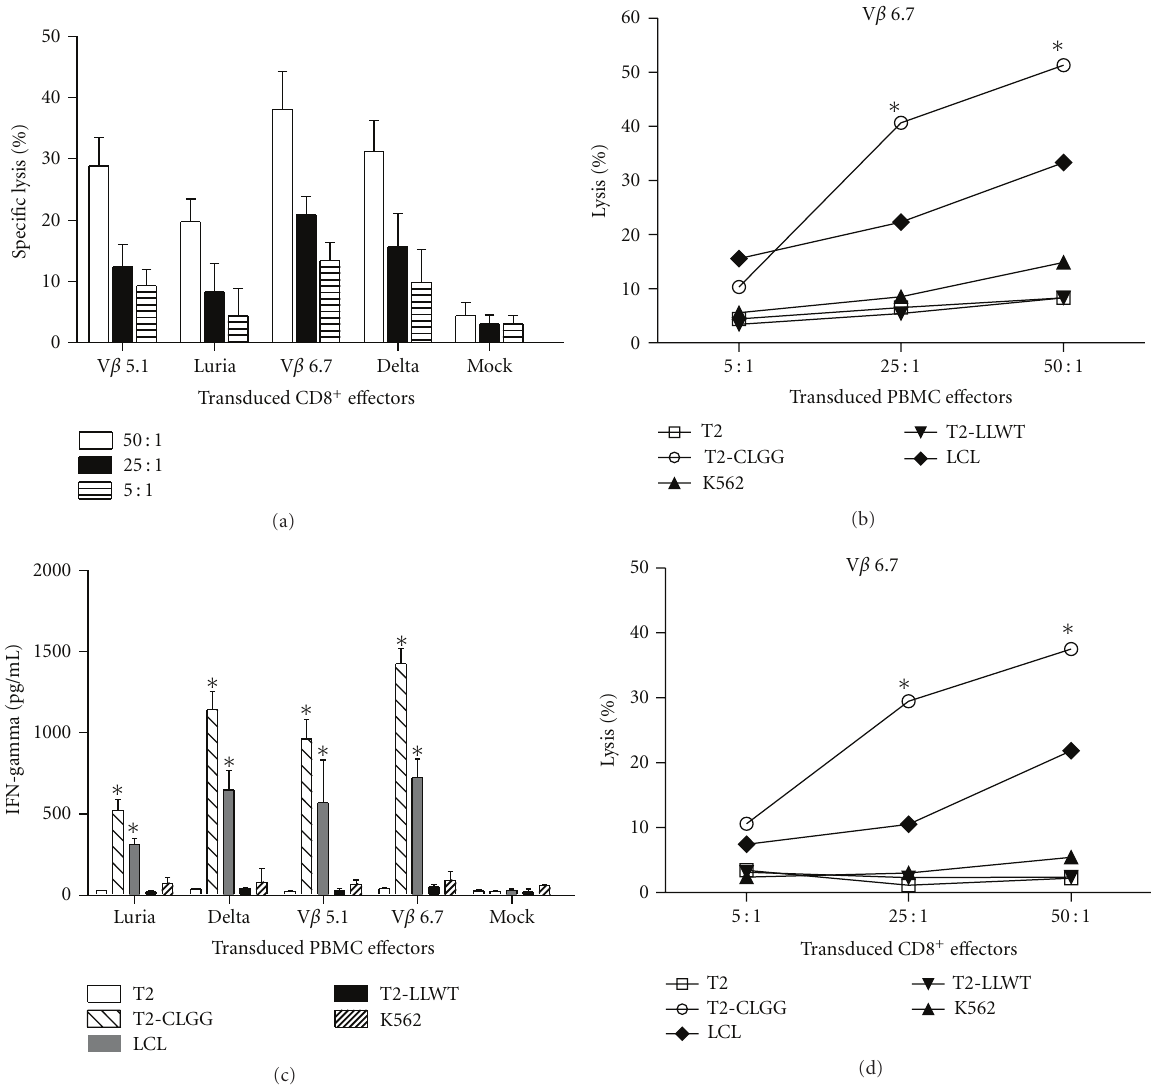
Figure 4: Transduced PBMCs specifically lyse HLA-A2-restricted LMP2-expressing target cells. (a) Lytic activity of CD8 + cells selected from PBMCs transduced with lentivirus containing LMP2-TCR at indicated e ff ector-to-target cell ratios (E:T) was demonstrated in an LDH- release assay. Targets were HLA-A2-restricted T2 cells loaded with CLGG. Results are expressed as percent of the value measured in control cells incubated with the same volume of medium (mean ± SD of 3 replicates). Lytic activity of PBMCs (b) or CD8 + cells (d) selected from PBMCs transduced with lentivirus-containing LMP2-TCR driven by T-cell promoter V β 6.7 at indicated E:T was demonstrated in an LDH- release assay. Targets were HLA-A2-matched T2, T2-CLGG, LCL, T2-LLWT, and exceptional K562 cells. All figures are representative of 3 or more experiments using the same PBMC donor. (c) Levels of IFN- γ being released into the media from transduced PBMC e ff ectors in the lysis assay above. PBMCs expressing LMP2-TCR were cocultured for 16hr with the indicated target cells. The concentration of IFN- γ secreted into the medium was measured in an ELISA